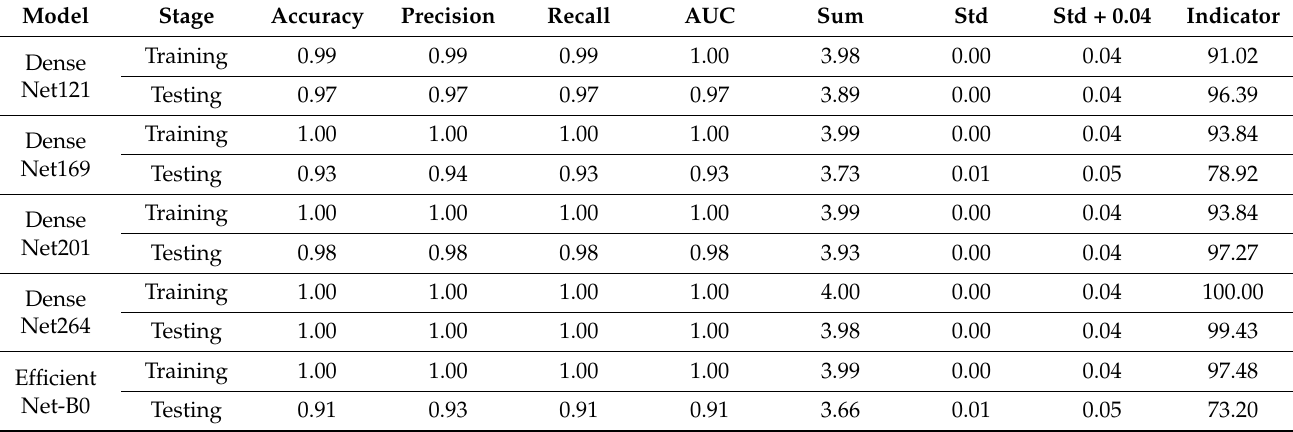
Table 12. The acquired comprehensive indicators of all DL model performance indices for AD vs.